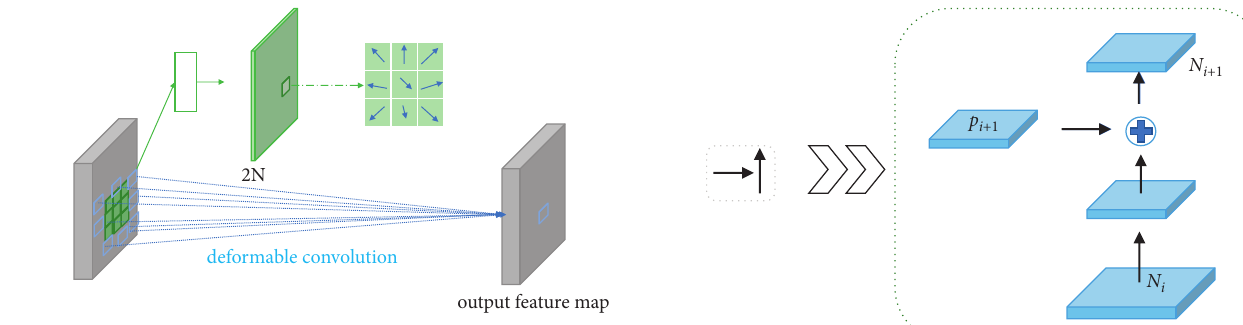
Figure 3: Illustration of 3 × 3 deformable convolution. 2N rep- resents the deviation in the x and y directions, respectively. Figure 4: Block diagram of bottom-up path augmentation.